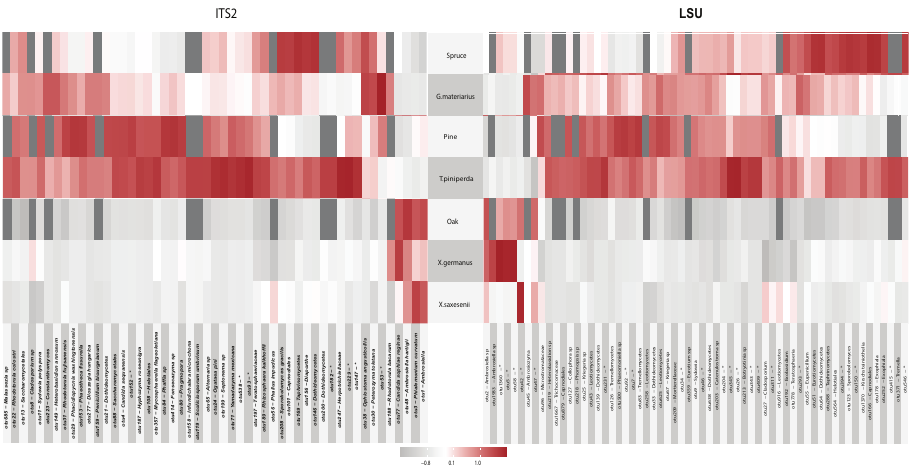
Figure 4. Heatmap using Pearson’s correlation coefficient between the OTUs generated from the ITS2 and LSU D1-D2 metabarcodes and the analysed beetle species and forest types. Rectangles indicate the strength of association between an OTU and beetle/forest (strongly negative, grey, to strongly positive, red). Fungal OTUs (on the horizontal axis) were classified to genus or species level where possible; they are shown in random order and cannot be linked taxonomically between both Table 3. Sequence numbers and phylogenetic dispersion in Sordariomycetes OTUs under different threshold values. The table presents the Net relatedness index (NRI), nearest taxon index (NTI), and the number of OTUs recovered for ITS2 and LSU D1-D2. “Mixed” refers to a clustering threshold of 99% for LSU D1-D2 and 98% for ITS2. Reference sequences were included when building the trees used, though pruned (leaving only OTUs in the tree) for the above calculations. Positive NRI and NTI scores indicate phylogenetic clustering of either ITS and LSU sequences (indicating different species sets were sequenced), negative values indicate phylogenetic over-dispersions of ITS and LSU with respect to each other (indicating the same species was sequenced for the two markers).